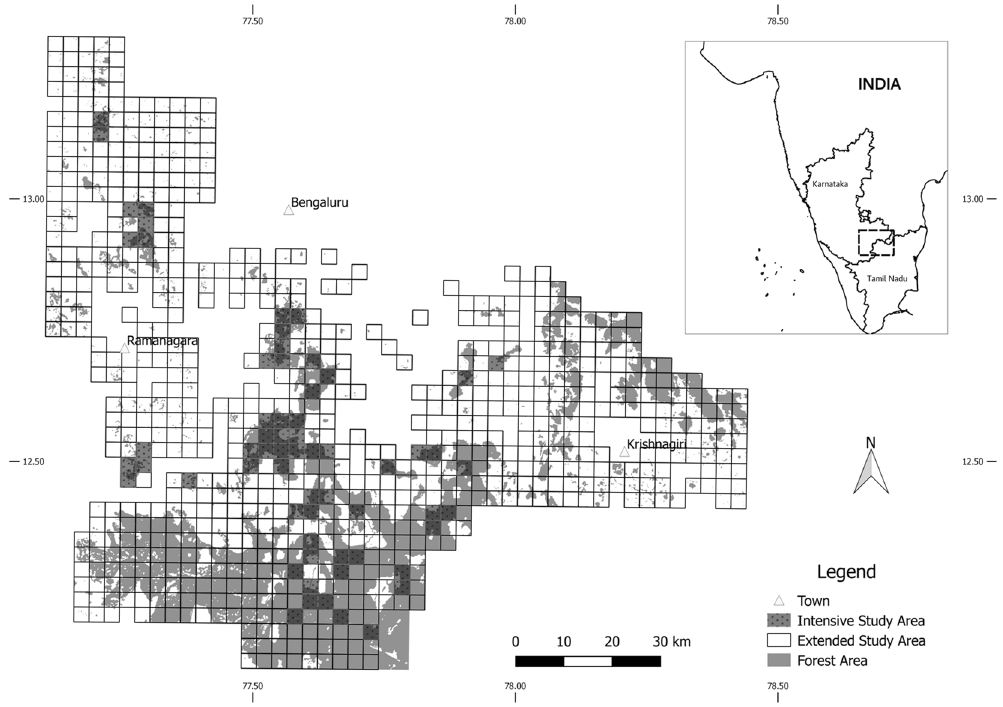
Figure 4. Map of the study area in southern India showing a matrix of forested and non-forested habitats of the study elephant population, the survey area and the intensive study